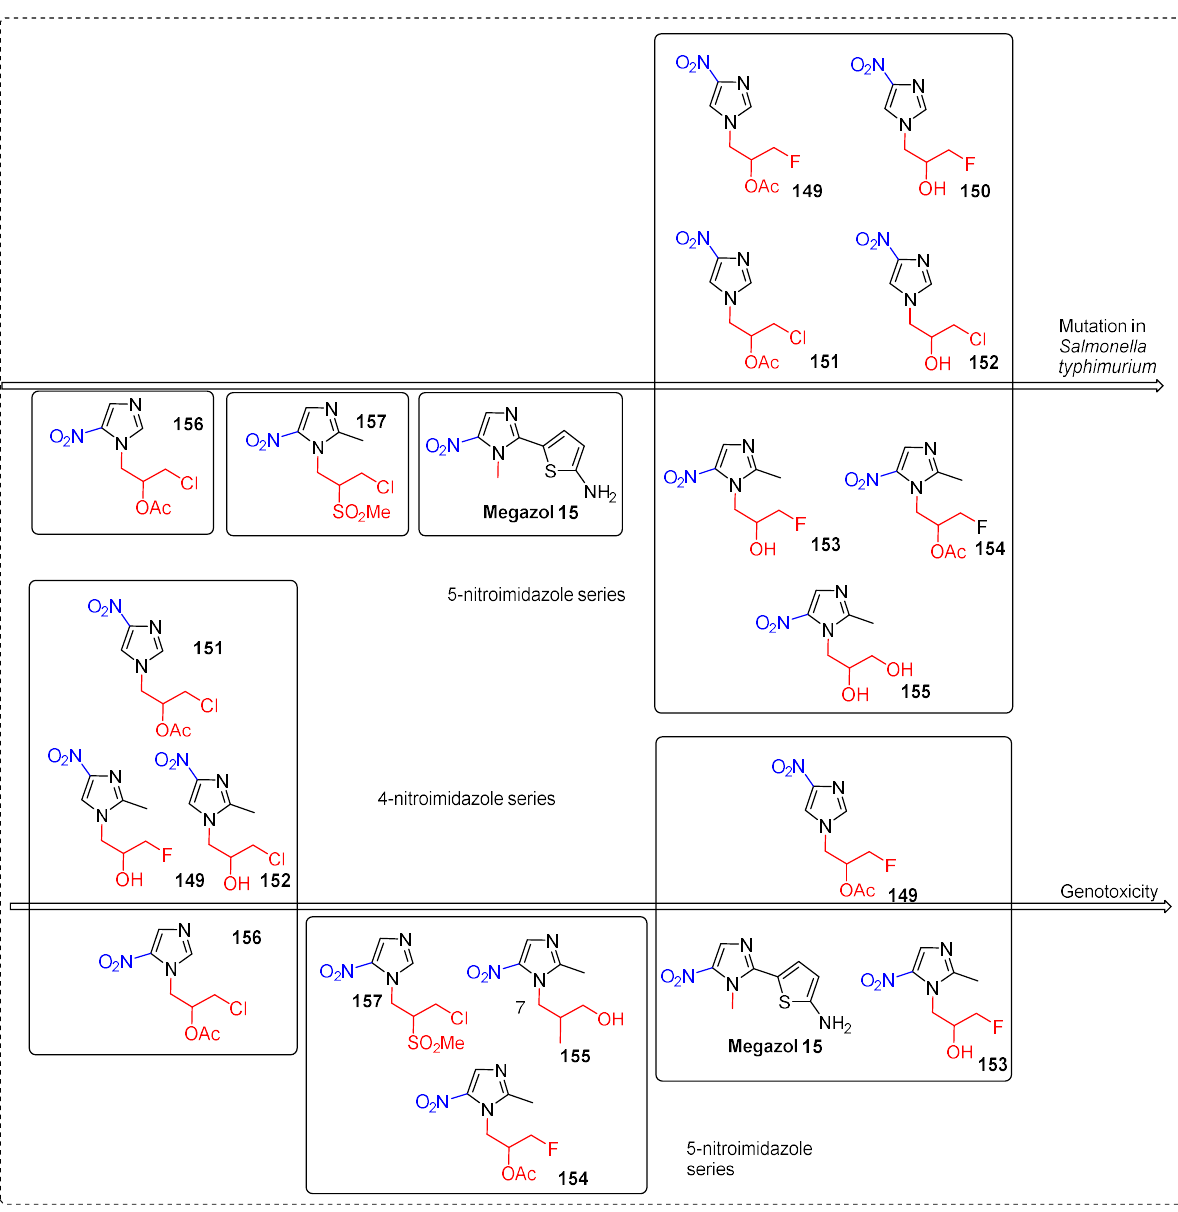
Figure 30. Genotoxicity (comet assay) and mutagenicity ( Salmonella typhimurium ) of nitroimidazoles.